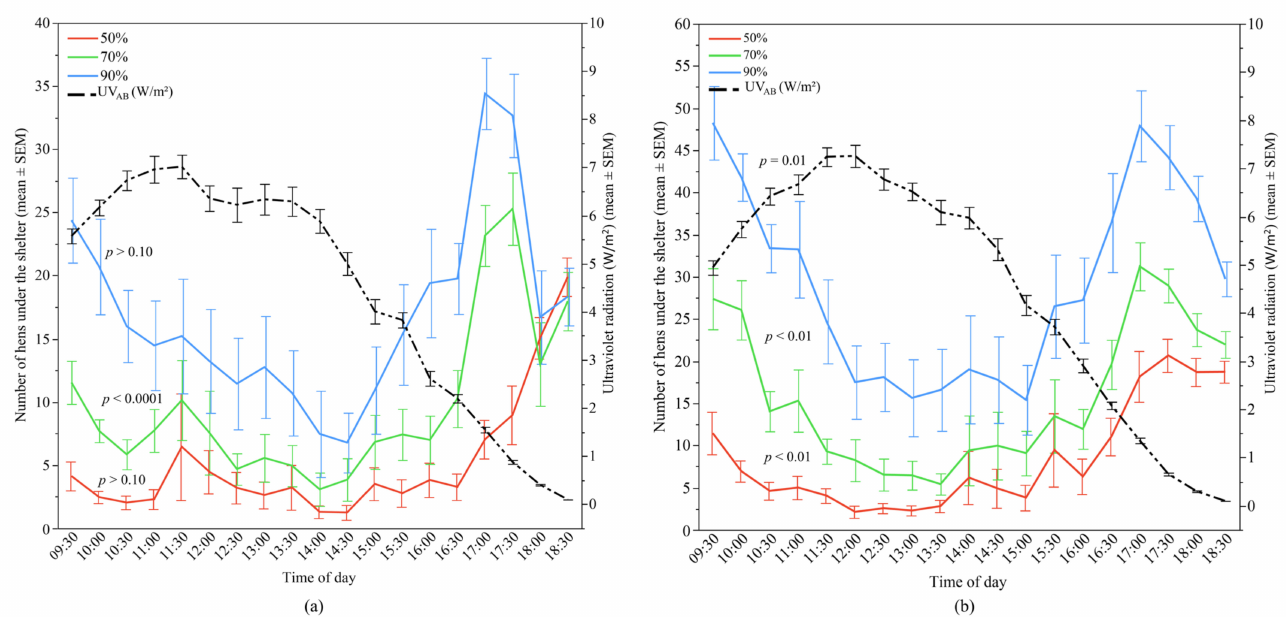
Figure 8. The mean ( ± SEM) number of hens under the different UV-filtering shelters (50%, 70%, and 90%) and the mean ( ± SEM) ultraviolet (UV AB ) radiation throughout the day: ( a ) Flock-A; ( b ) Flock-B ( p > 0.10 indicates the variable had no significant effect and was removed from final model). Note the different Y-axis scales between Flock-A and Flock-B. Raw values are presented with analyses conducted on transformed data.